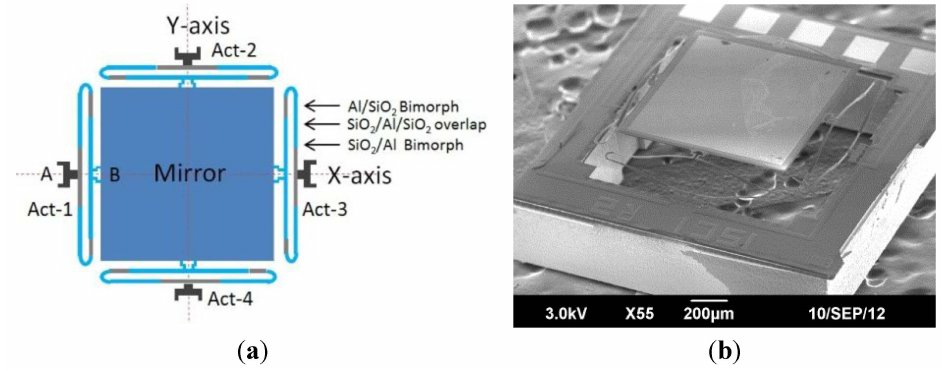
Figure 1. Two-axis ISC MEMS mirror. ( a ) Device design: there are four ISC actuators whose A ends are anchored on the substrate and B ends connect to the central mirror plate; ( b ) SEM of a fabricated device: the initial elevation of the mirror plate is 240 µ m, the mirror plate is 1.0 mm ˆ 1.0 mm, and the whole device size is 1.5 mm ˆ 1.5 mm.